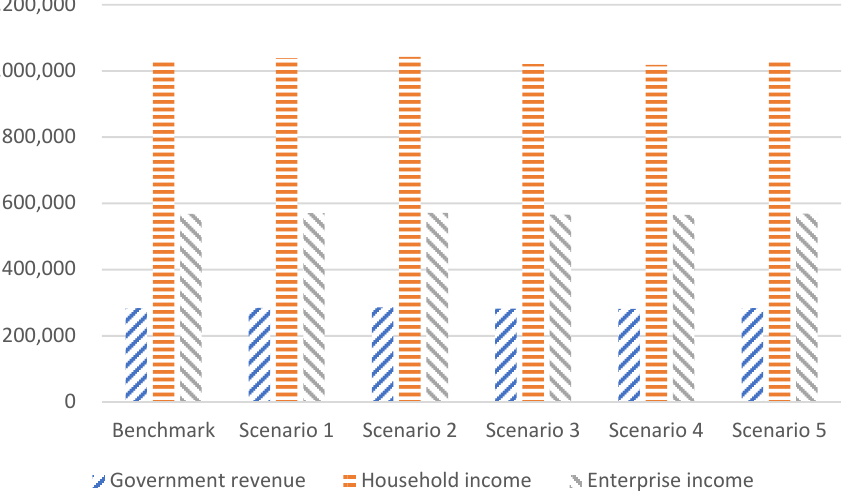
Figure 8. Institutional income in different scenarios in 2030 (CNY 100 million).